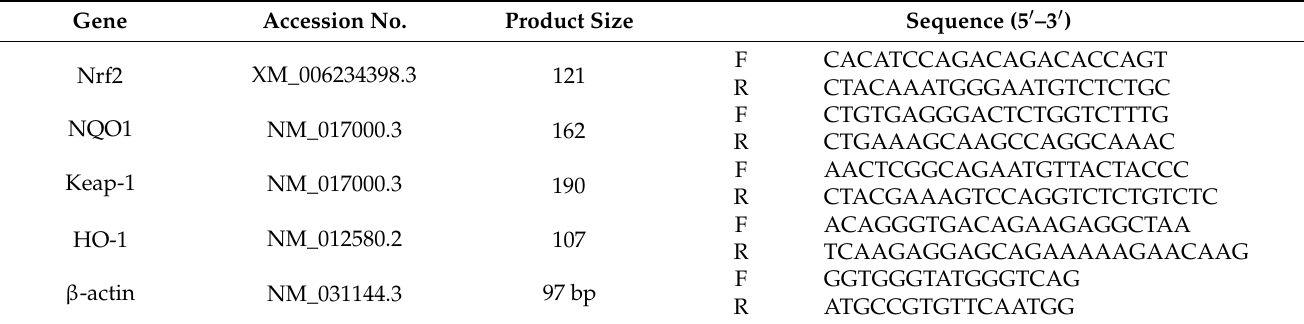
Table 1. Primers used for